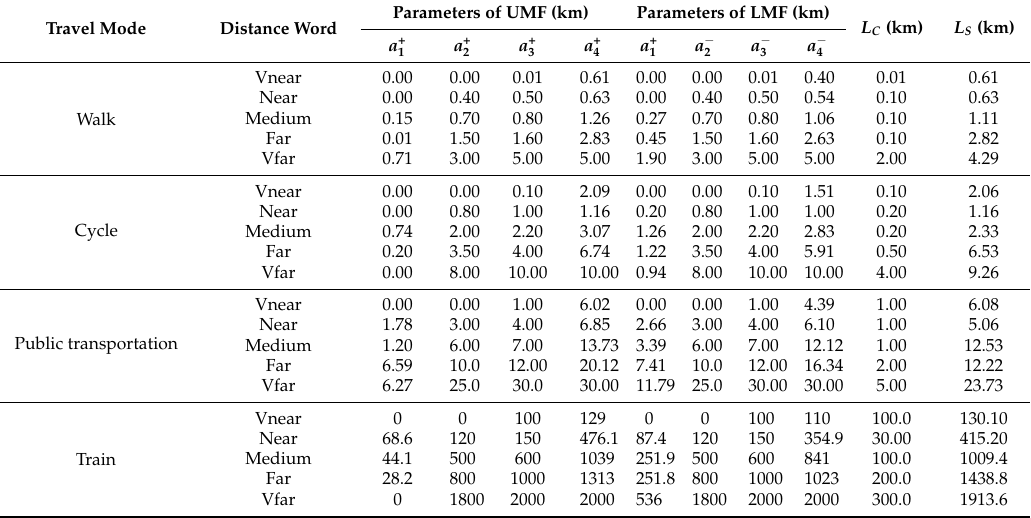
Table 1. Parameters of IT2 FSs corresponding to five qualitative distance words for four travel